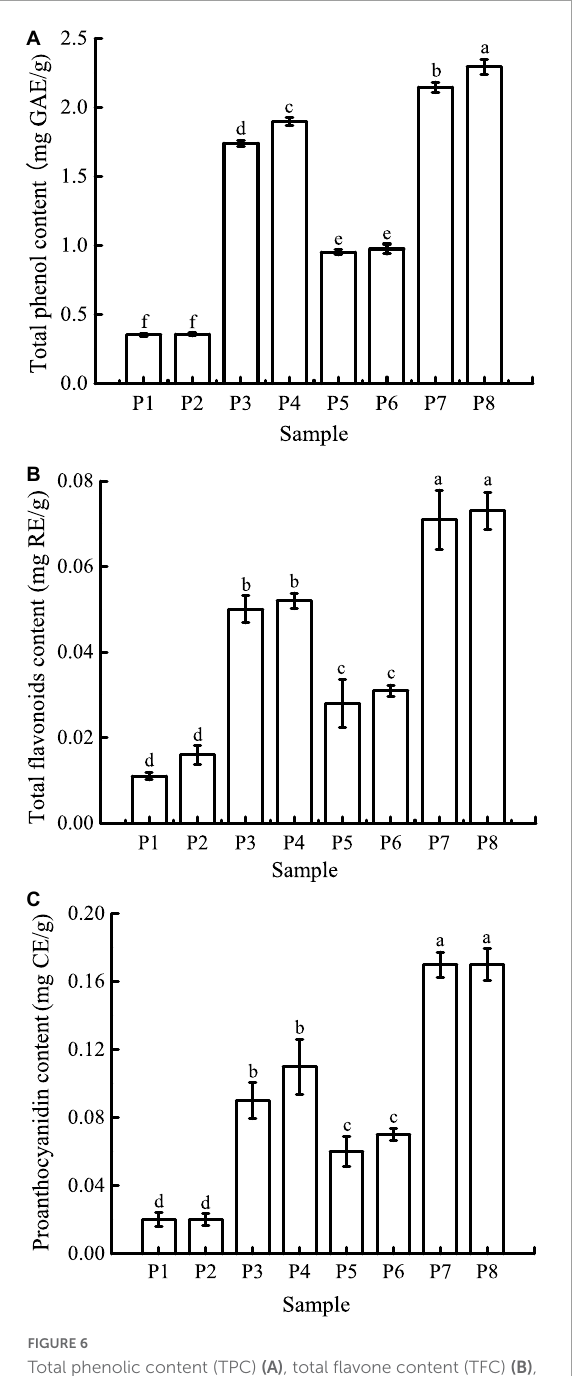
FIGURE6 Total phenolic content (TPC) (A) , total flavone content (TFC) (B) , and proanthocyanidin content (PC) (C) of samples in different simulated digestion stages. Data with different lowercase letters indicate significant differences ( P <